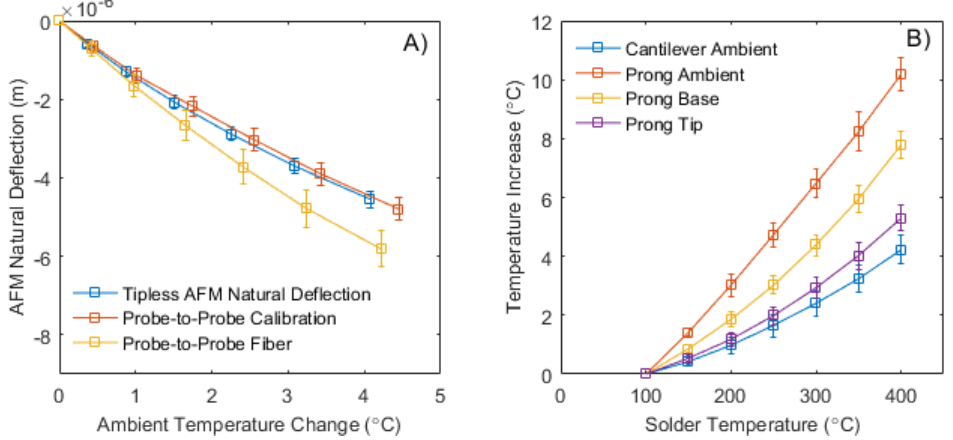
Figure 3. ( A ) Response of AFM cantilever with increasing ambient temperature during calibration and experimental scans. ( B ) Appended nanofiber temperature recordings at appended thermocouple positions ( T ∞ c , T ∞ p , T pb , and T f ) with increasing input solder temperature [27].